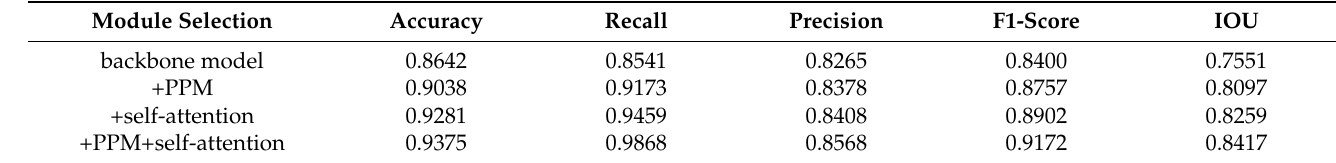
Table 7. Ablation study.